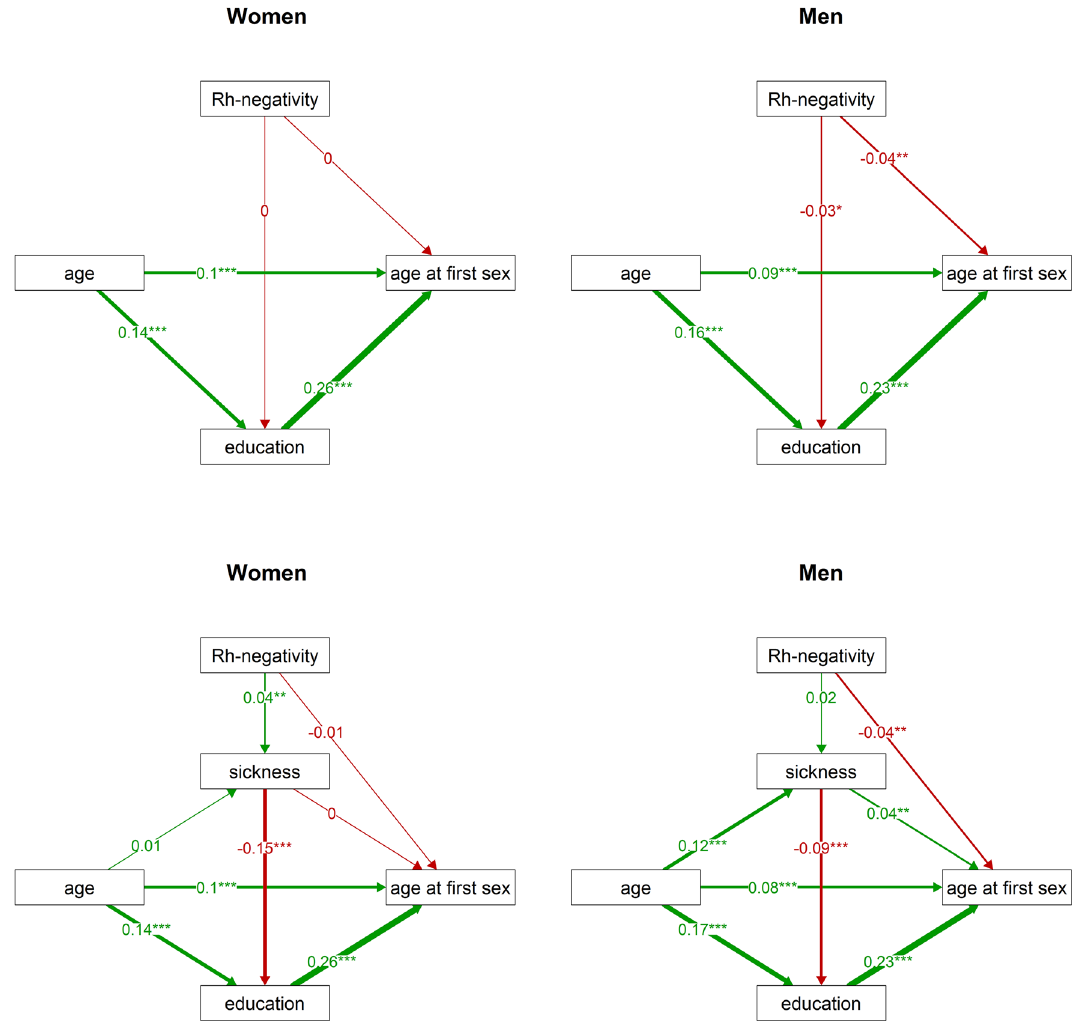
Figure 5. Direct and indirect effects of Rh-negativity on age at first sexual intercourse in women and men. This figure displays the results of path analyses of relations between age at first sexual intercourse, Rh-negativity, education, and age (top), and relations between these variables and the sickness index (bottom) for women (left) and men (right). The numbers at arrows show standardised parameter estimates. Associations with p values under 0.01 are marked by ‘**’, and those with p values under 0.001 are marked by